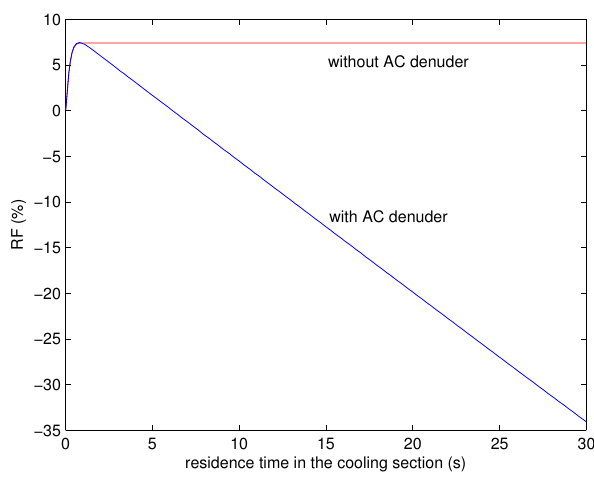
Fig. 8. Maximum re-condensation fraction as a function of resi- dence time in the cooling section with and without an AC denuder for C n =0.5. Negative RF indicates net evaporation of the aerosol relative to its state at the entrance of the heated